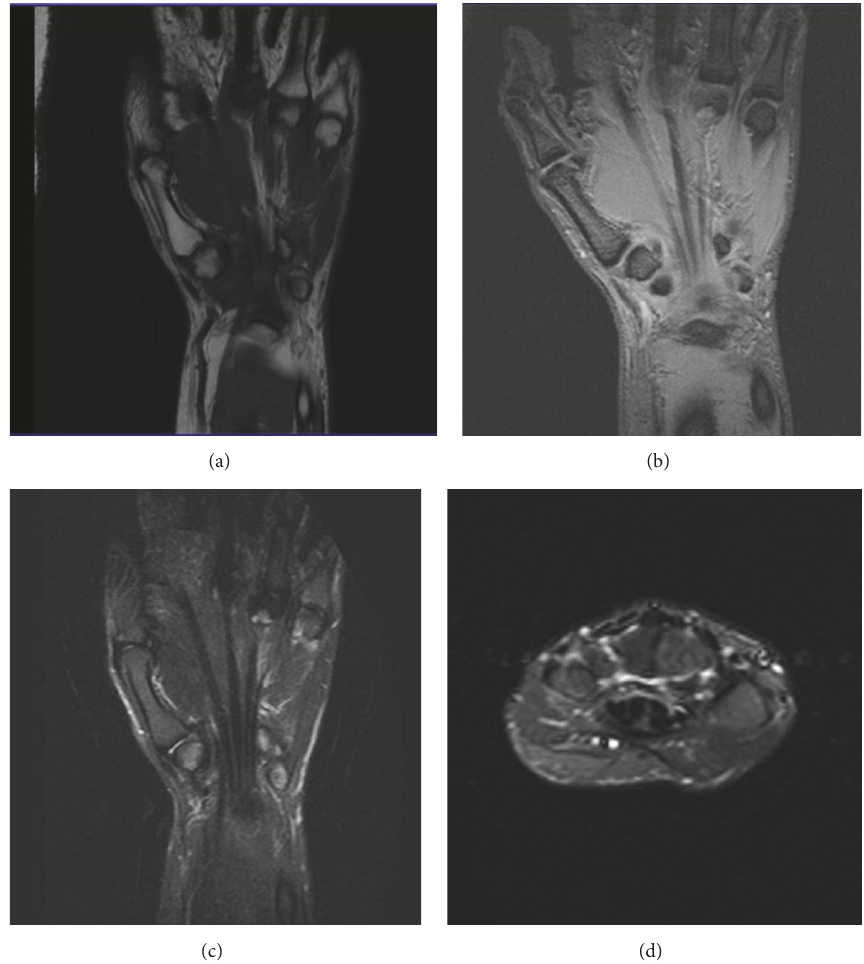
Figure 2: After three months, an MRI scan reveals an almost normal trapezium with patient’s symptoms fully subsided. (a) TIWI coronal image. (b) PD coronal image. ((c) and (d)) STIR coronal and axial